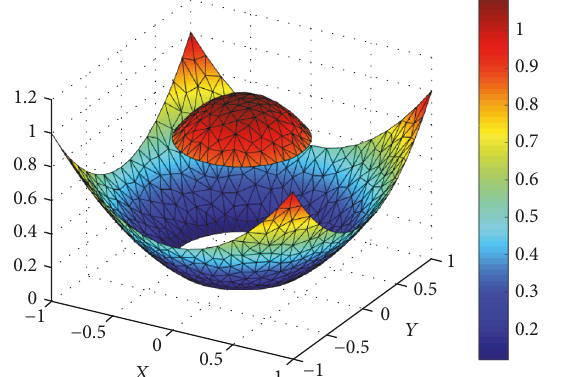
Figure 2: Numerical solution of Example 1.